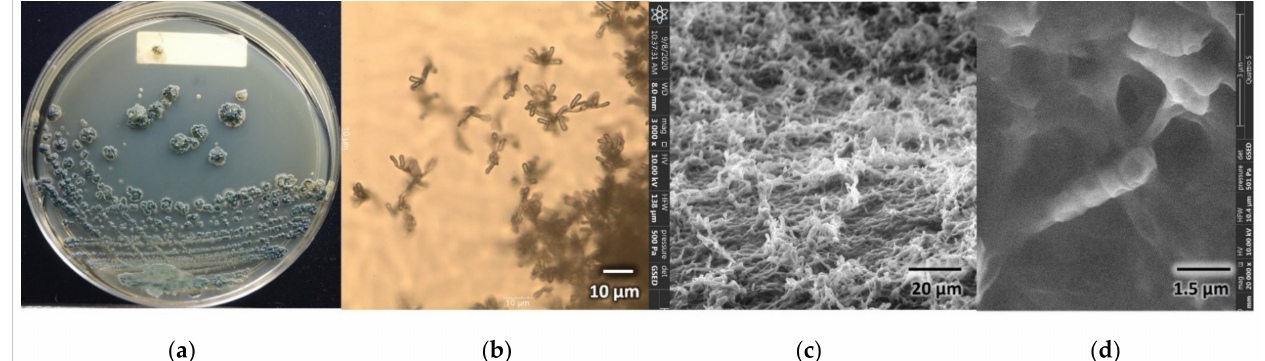
Figure 1. Microtetraspora sp. AC03309 morphology: ( a ) surface colony morphology on Yeast Malt Extract (ISP2) agar; ( b ) spore-forming structures viewed using light microscope at 750 × magnification on Soil Extract agar (SEA); ( c ) sporophore branching from aerial mycelia viewed using Field Emission Scanning Electron Microscope (FESEM, Quattro Thermo Fisher Scientific, Lanham, MD, USA); ( d ) sporophore with four spores viewed using Field Emission Scanning Electron Microscope (FESEM, Quattro Thermo Fisher Scientific, Lanham, MD,